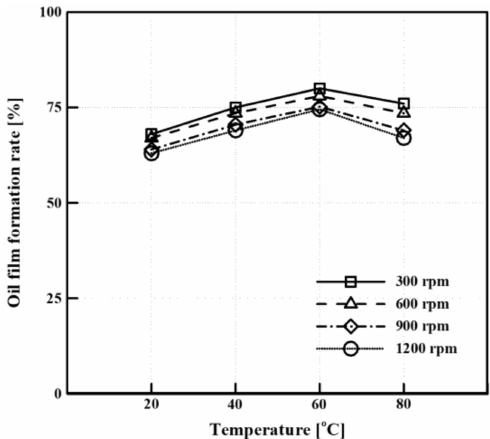
Figure 5. Oil film formation rate based on temperature at 0.084 kg/s.